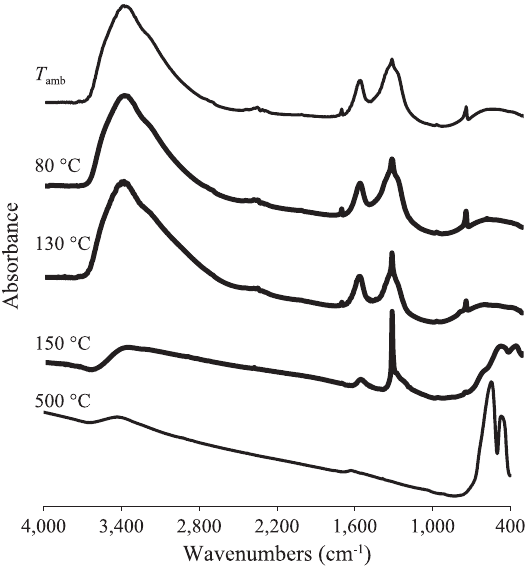
Fig. 12 FTIR spectra of samples heated in the furnace. Fig. 13 Photos of samples heated in the